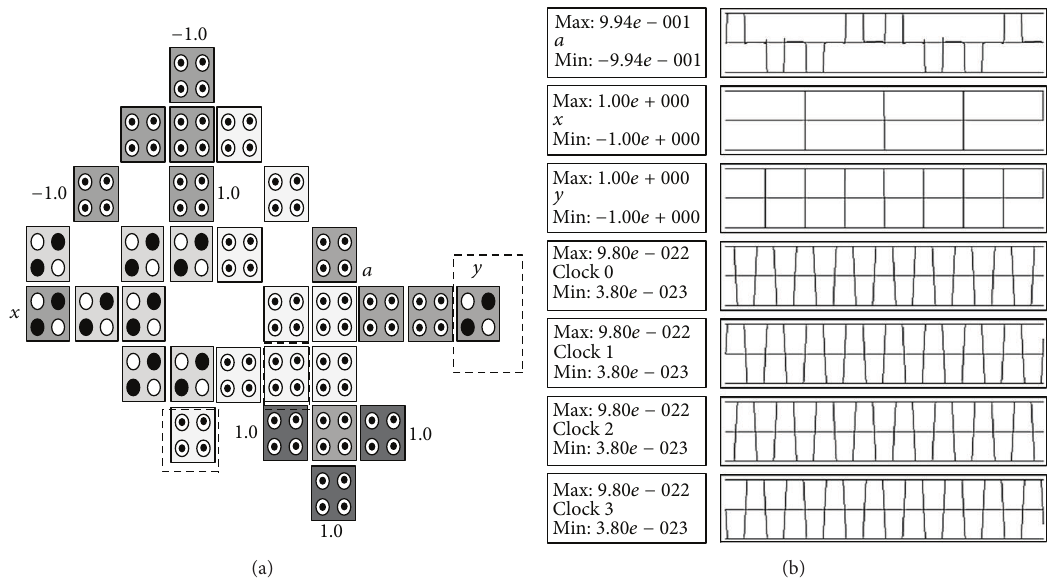
Figure 9: The proposed QCA for the XNOR gate: (a) the layout where the added cells to the basic building block are highlighted with dashed line, (b) the simulation results.